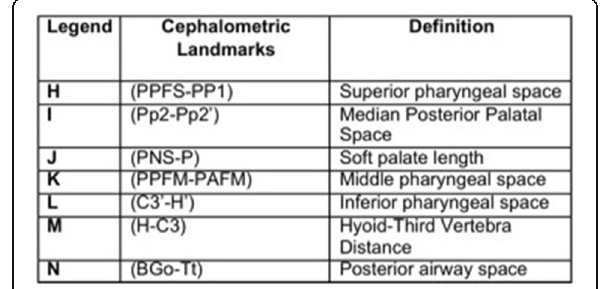
Fig. 3 Legend, cephalometric landmarks, and